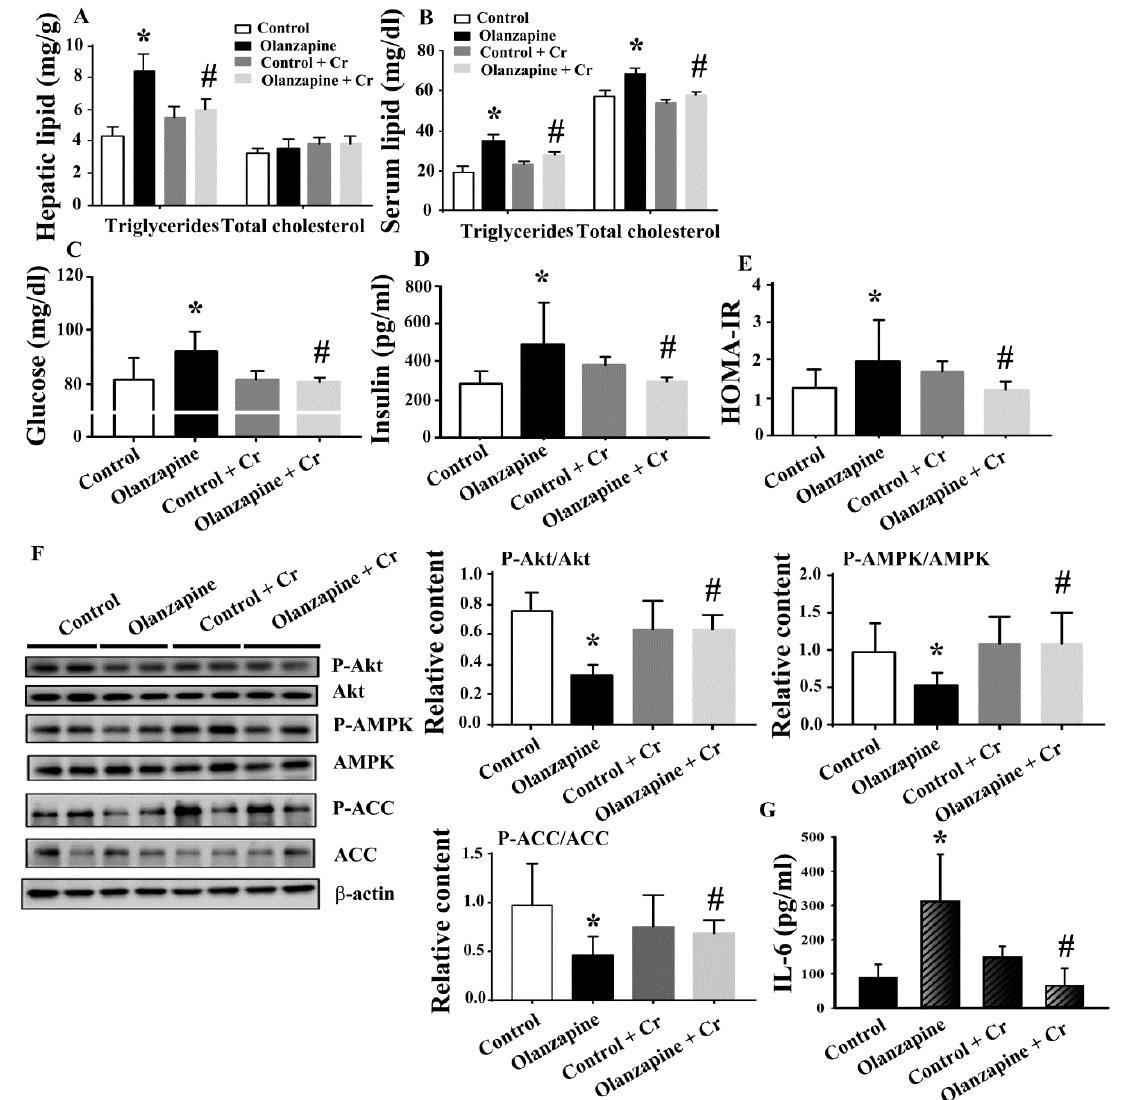
Figure 6. Chromium improved olanzapine-induced metabolic disturbance. At the end of the experiments, tissue lipids were homogenized and extracted from livers and subjected to an enzymatic assay for the measurement of hepatic triglycerides and cholesterol ( A ). Serum samples were subjected to analyses for the measurement of lipids ( B ), fasting glucose ( C ), and insulin ( D ). The value of HOMA-IR is depicted in ( E ). ( F ) Proteins were extracted from the excised liver tissues and subjected to Western blotting with indicated antibodies. Representative blots are shown, and the quantitative data are depicted. ( G ) Serum samples were subjected to analyses for the measurement of IL-6. * p < 0.05 vs. control and # p < 0.05 vs. olanzapine control, n = 10.